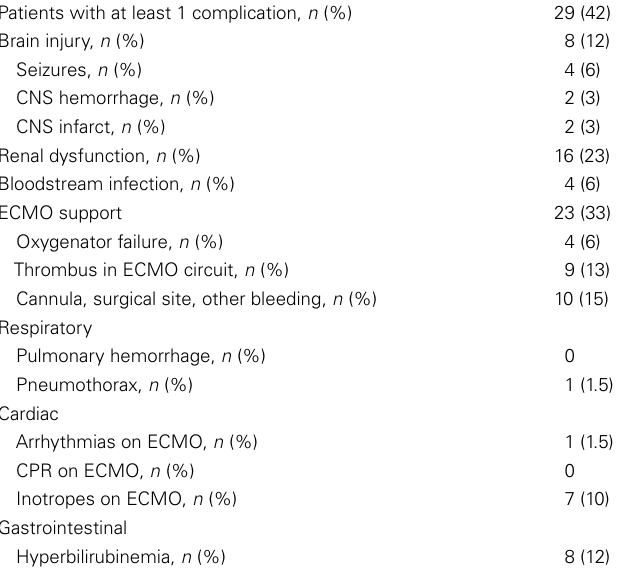
Table 5 | Incidence of complications.